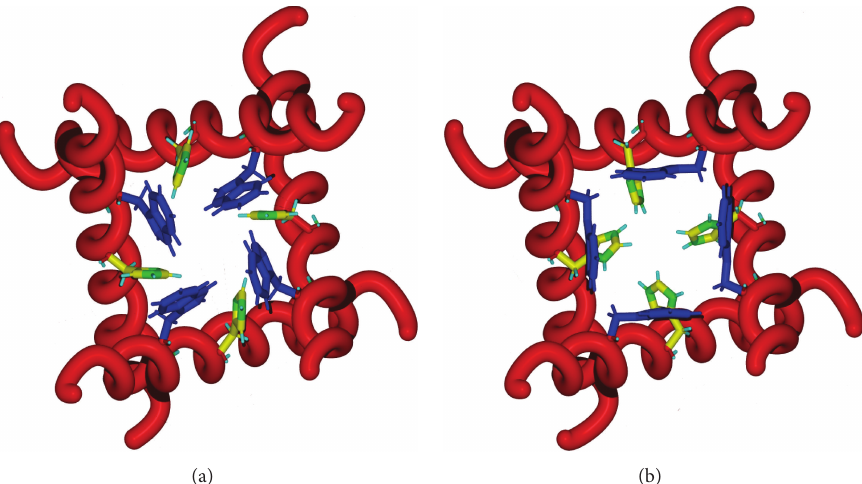
Figure 9: Side chain conformations of Trp-41 and His-37 in the transmembrane channel structure of the homotetrameric M2 protein. Representatives of (a) closed state at pH 8 for Trp-41: ( 𝜒 1 , 𝜒 2 ) = ( − 115 ∘ ± 50 ∘ , +130 ∘ ± 30 ∘ ), His-37: ( 𝜒 1 , 𝜒 2 ) = ( − 180 ∘ ± 20 ∘ , − 140 ∘ ± 20 ∘ ) and (b) open state at pH 5 for Trp-41: ( 𝜒 1 , 𝜒 2 ) = ( − 60 ∘ ± 20 ∘ , +110 ∘ ± 20 ∘ ) and His-37: ( 𝜒 1 , 𝜒 2 ) = (+95 ∘ ± 20 ∘ , +130 ∘ ± 20 ∘ ) are